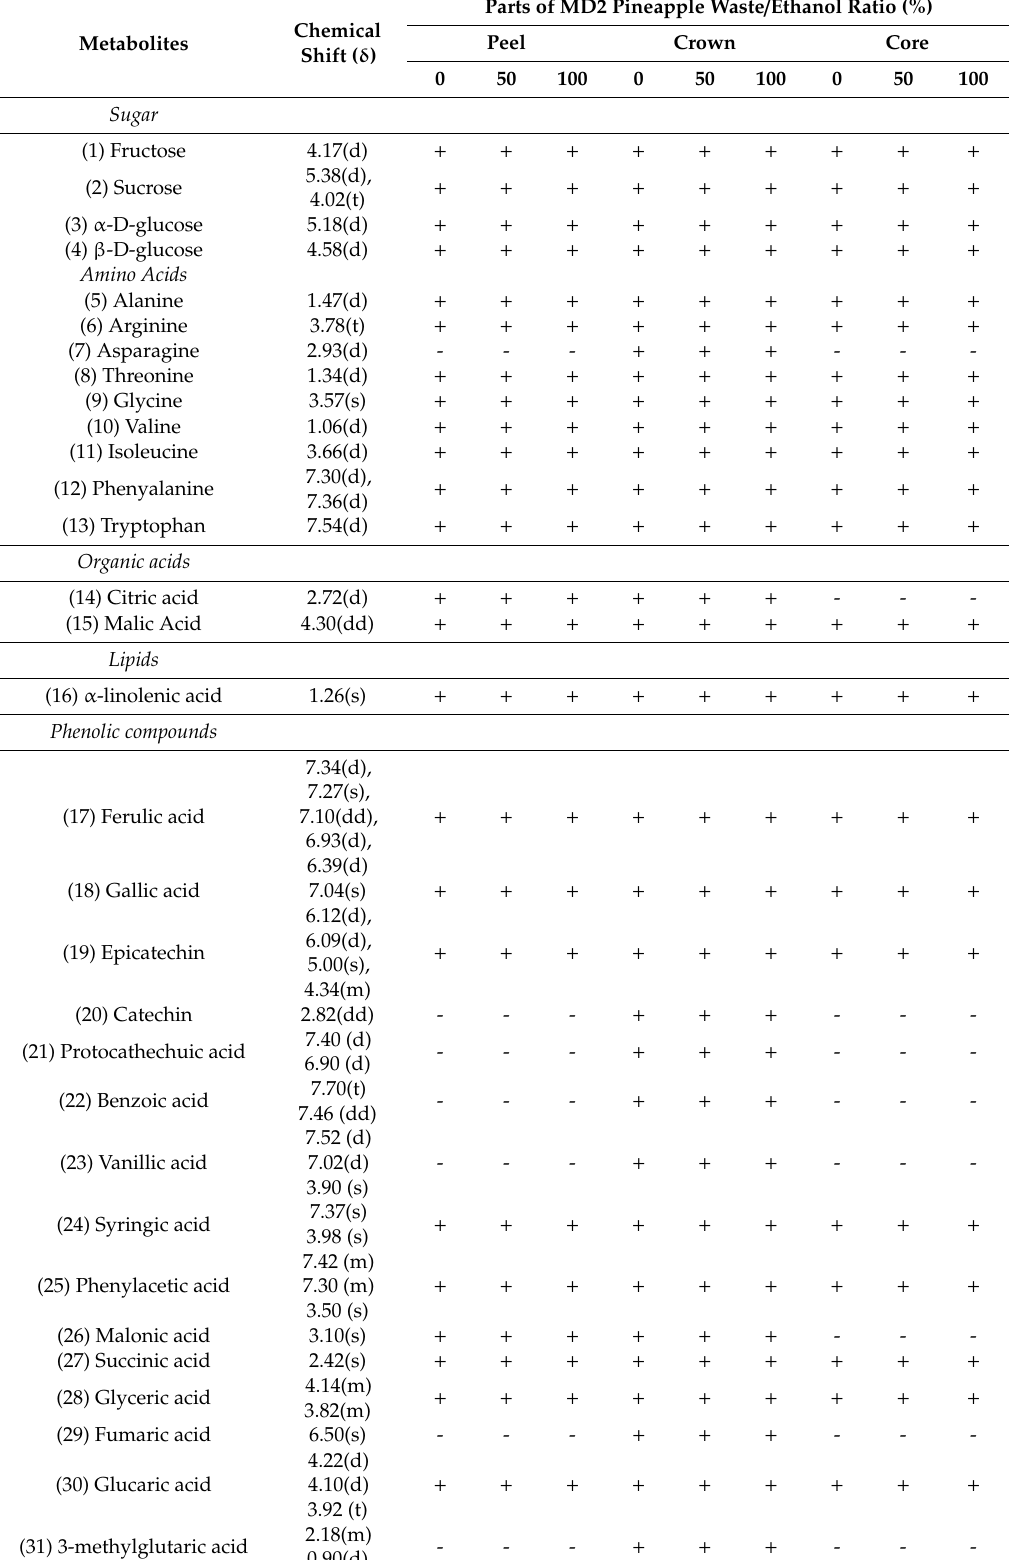
Table 2. Tentatively identified metabolites of 1 H NMR spectra from MD2 pineapple peel, crown and core extracted with 0, 50 and 100% ethanol